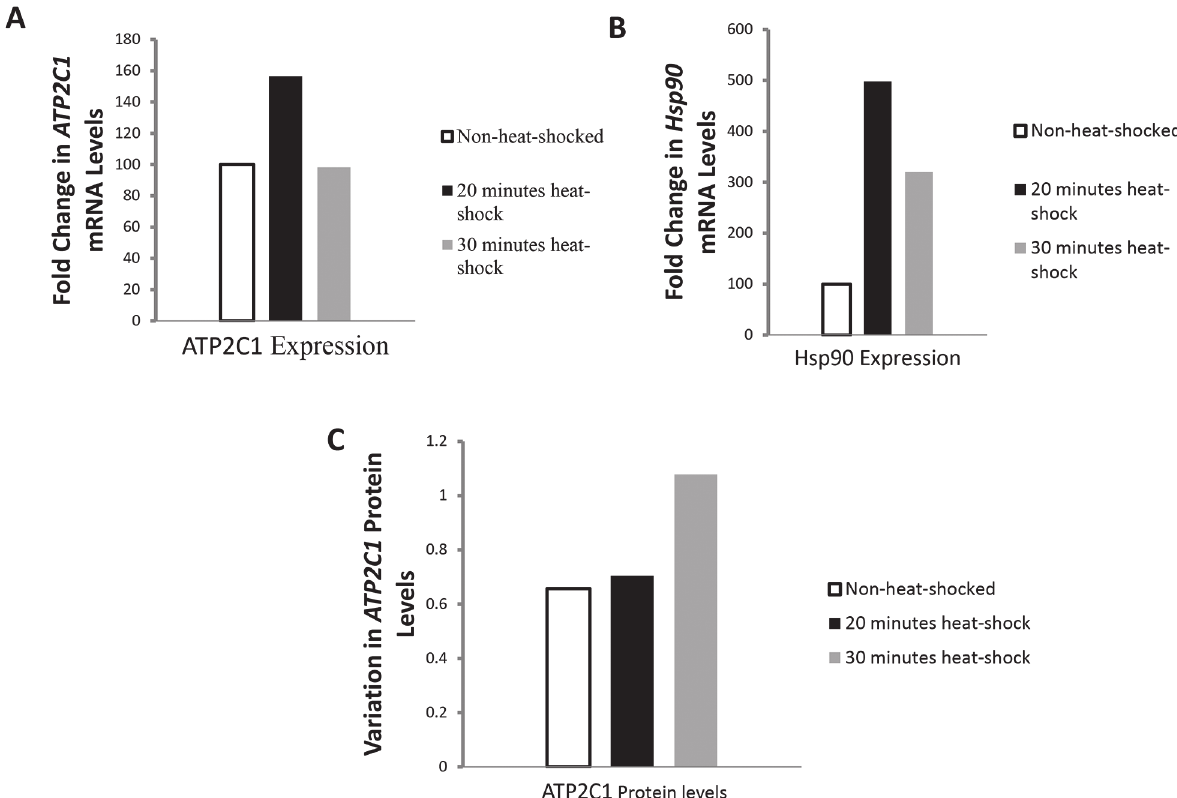
Fig 4. Effect of heat-shock on cardiomyocyte-ATP2C1 levels. (A) Fold change in ATP2C1 mRNA levels before and after heat-shock. (B) Fold change in Hsp90 mRNA levels before and after heat shock. (C) Variation in ATP2C1 protein levels before and after heat-shock.